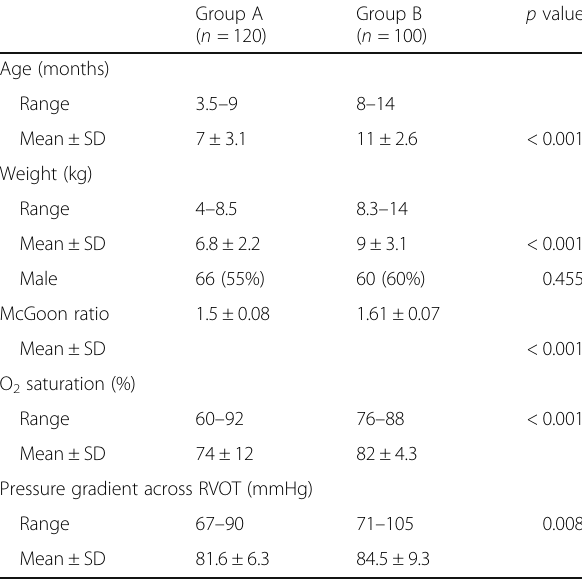
Table 4. Pericardial effusion was higher in group B